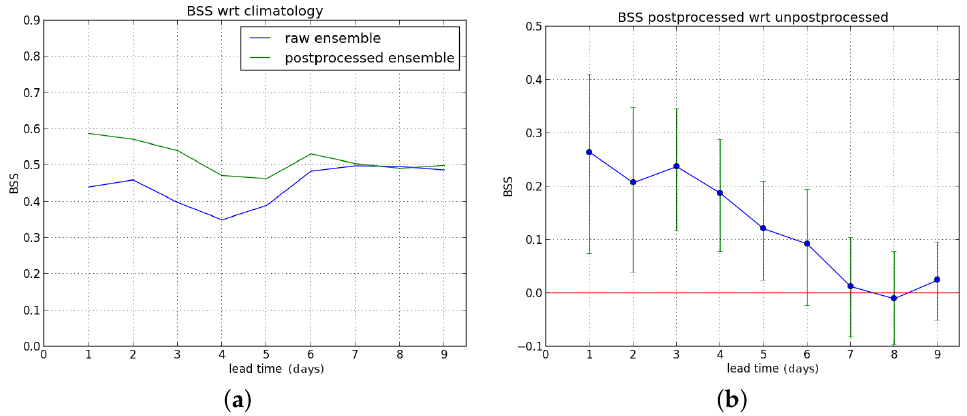
Figure 4. Brier Skill Score (BSS) for P90 threshold during entire verification period. ( a ) Compared to sample climatology; ( b ) Improvement due to